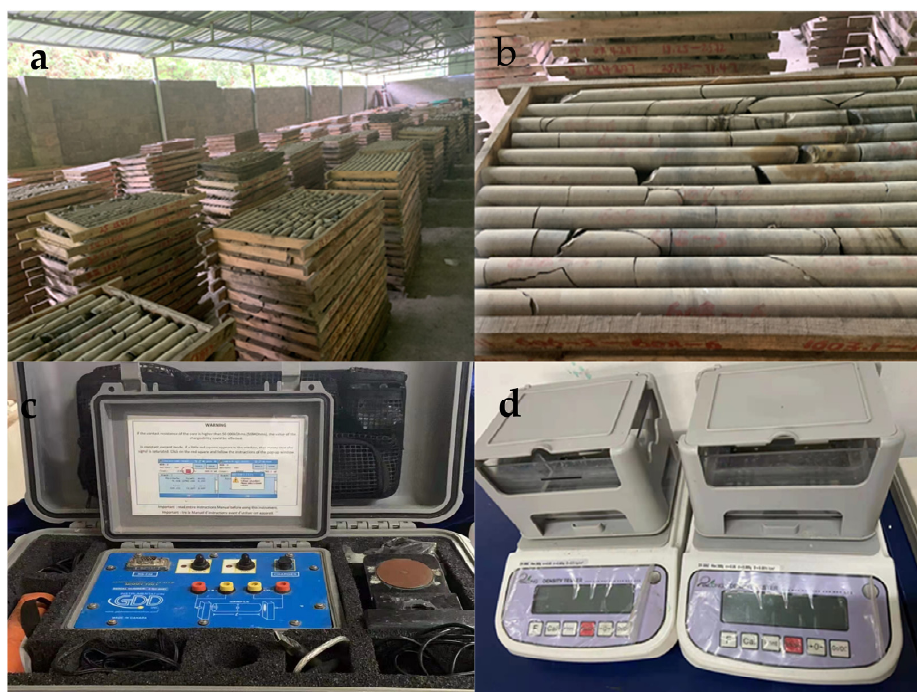
Figure A3. ( a ) Borehole sample collection; ( b ) partial borehole sample; ( c ) resistivity test equipment (SCIP); ( d ) density measuring equipment (DX-300Z).